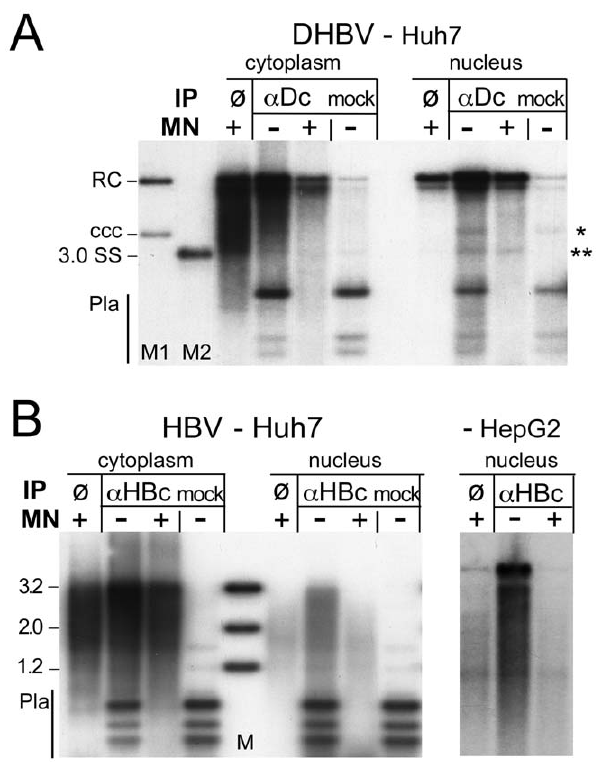
Figure 5. Core protein association of nuclear DHBV and HBV DNA. Vectors for surface-deficient DHBV and HBV genomes were transfected into Huh7 cells. IPs were performed in cytoplasmic extracts and extracts of purified nuclei containing 0.75 6 RIPA buffer, using antibodies against DHBV core protein ( a Dc) or HBV core protein ( a HBc); in the mock IPs a Dc was replaced by a HBc and vice versa. Immunopellets were treated with MN or not as indicated, and extracted after prior PK digestion. Purified DNAs from not MN-treated samples were digested with Dpn I. ø, extract directly treated with MN. ( A ) DHBV. M1, marker for cccDNA and rcDNA; M2, marker for single-stranded DNA; * and **, positions of cccDNA and ssDNA, respectively. ( B ) HBV. The rightmost panel shows the nuclear samples from an analogous experiment in HepG2 cells; the cytoplasmic samples are shown in Figure